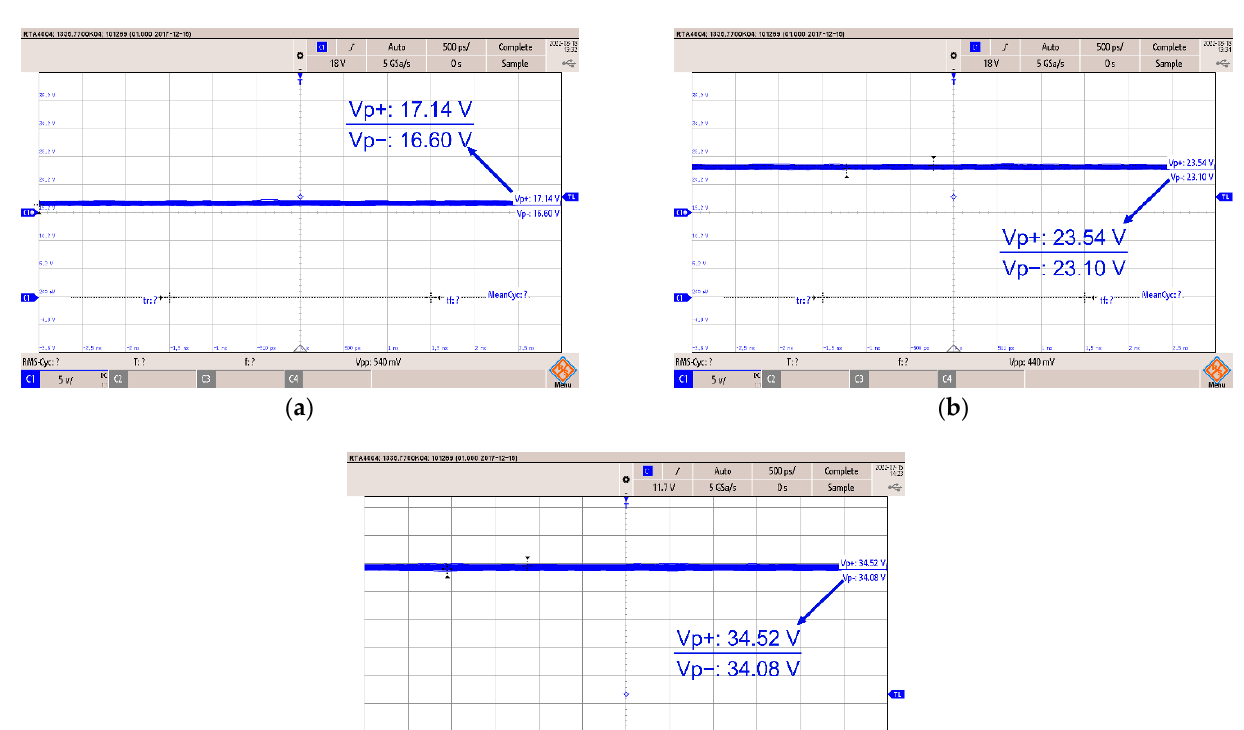
Figure 10. Hardware setup.